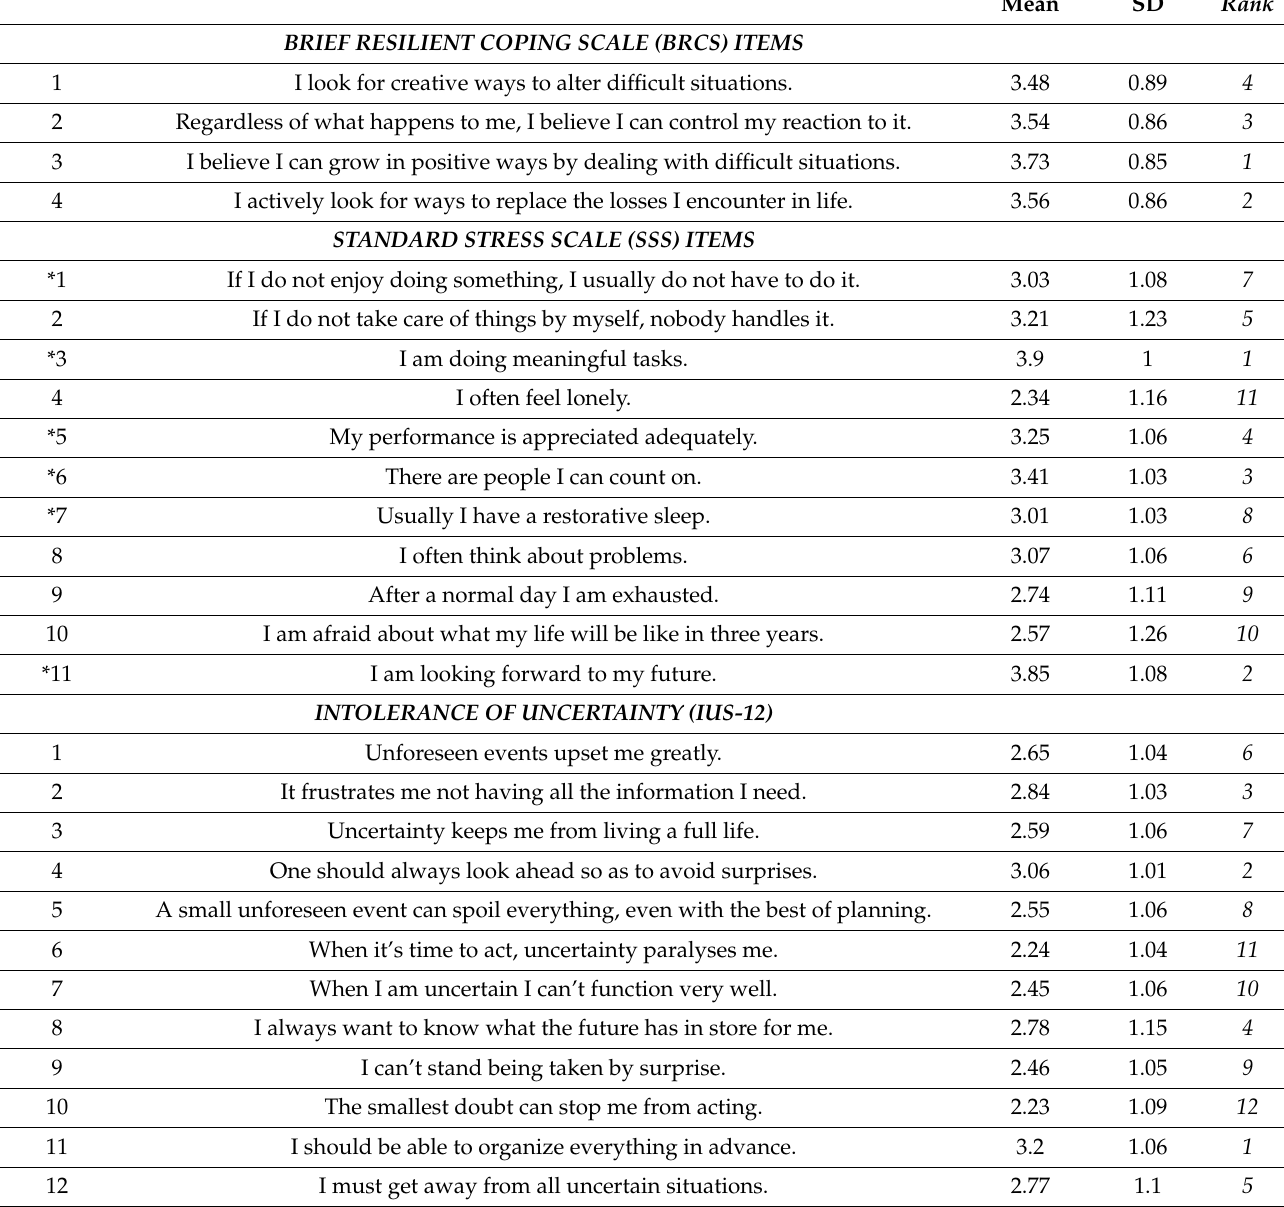
Table A1. Descriptive analysis of the HCWs’ perceived resilient coping, stress, and intolerance of